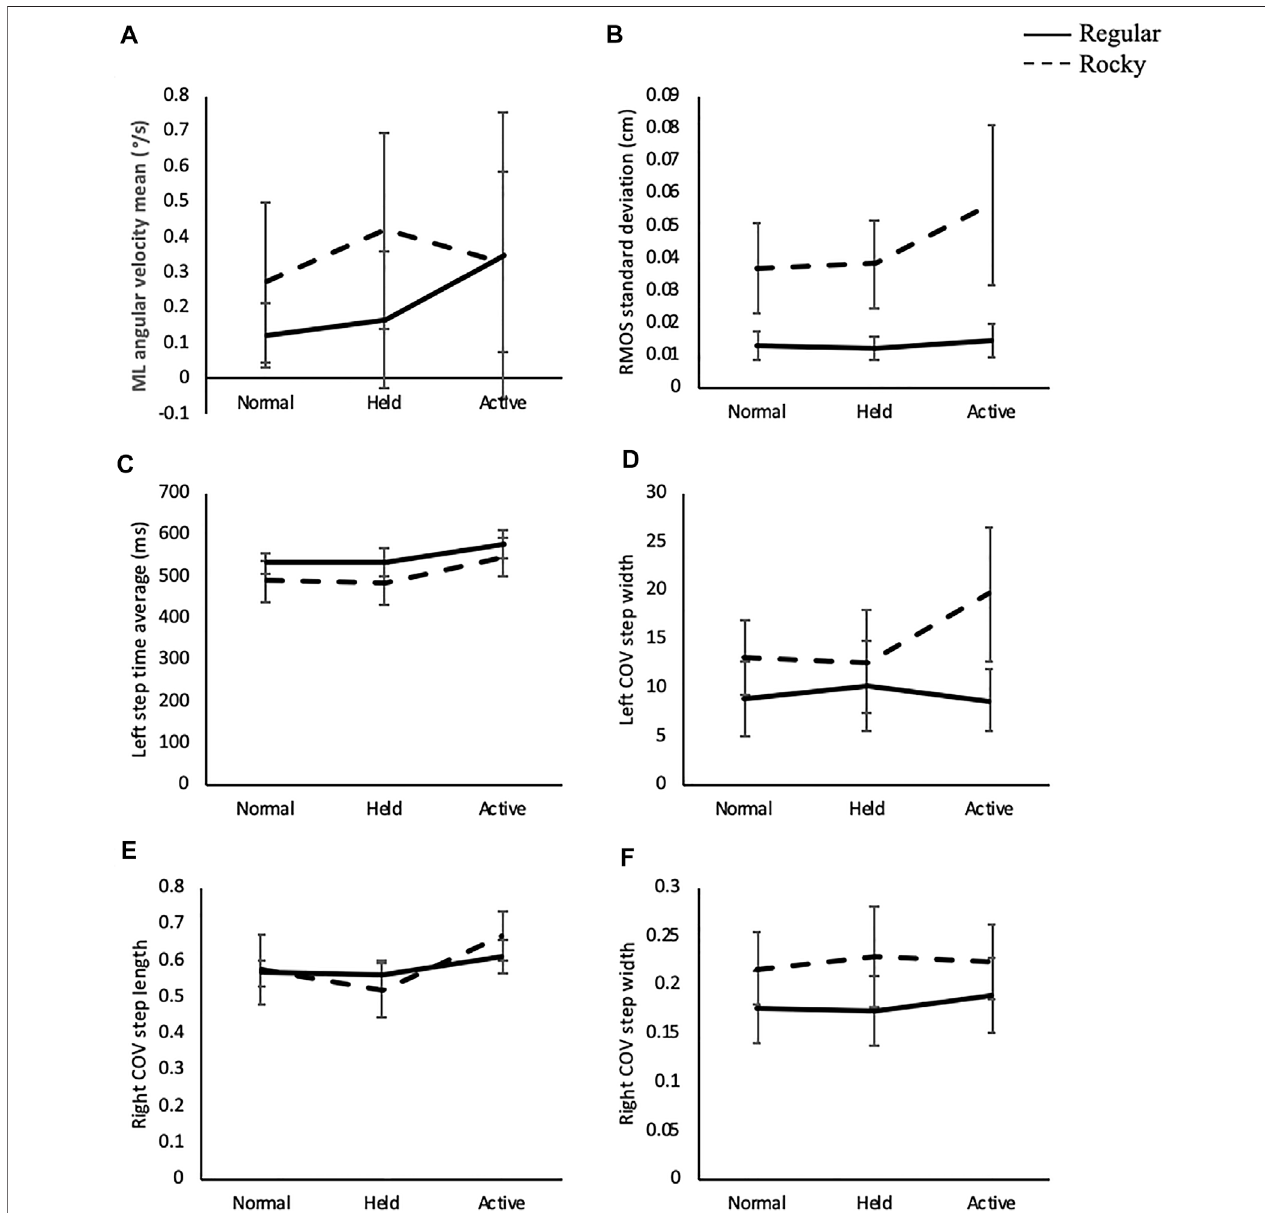
FIGURE 9 | Interaction fi gures according surface type and arm swing strategy used for (A) angular velocity mean ( /s) about the mediolateral axis, (B) MOS standard deviation at right heel strike (cm). (C) step time average (ms) at left heel strike, (D) COV of step width at left heel strike, (E) COV of step length (cm) and (F) step width (cm) at right heel